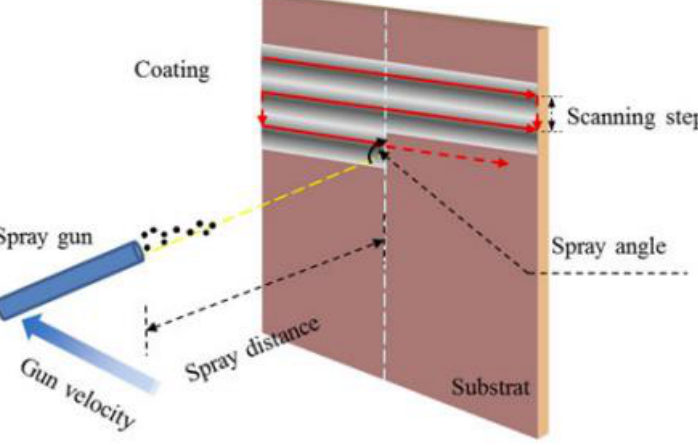
Figure 11. Schematic demonstration of the area spacing.